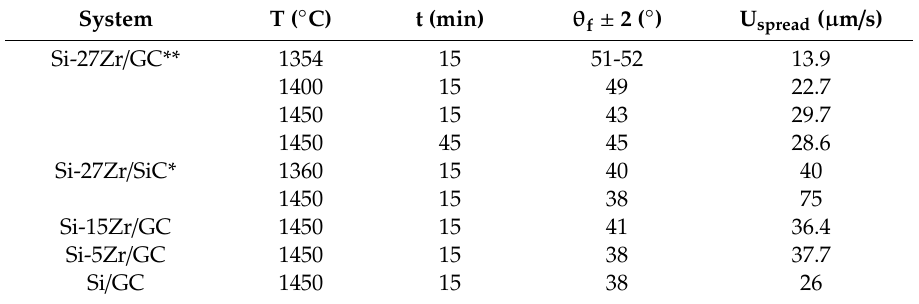
Table 1. Equilibrium contact angle values ( θ f ) and spreading rates (U spread ) that were measured for the liquid Si-rich Si-Zr in contact with GC and SiC as a function of temperature and time by the contact heating sessile drop method: (*) [30] and (**)